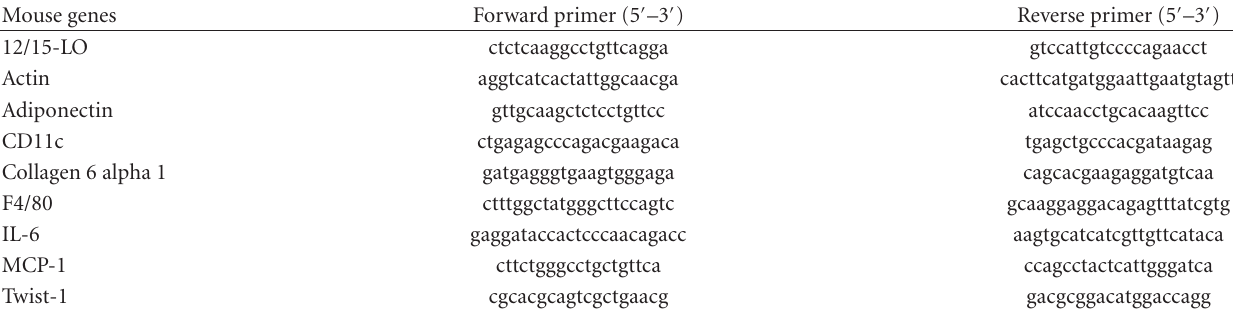
Table 1: Primer sequences used in SYBR-based real-time RT-PCR amplification of mouse cDNA. Mouse